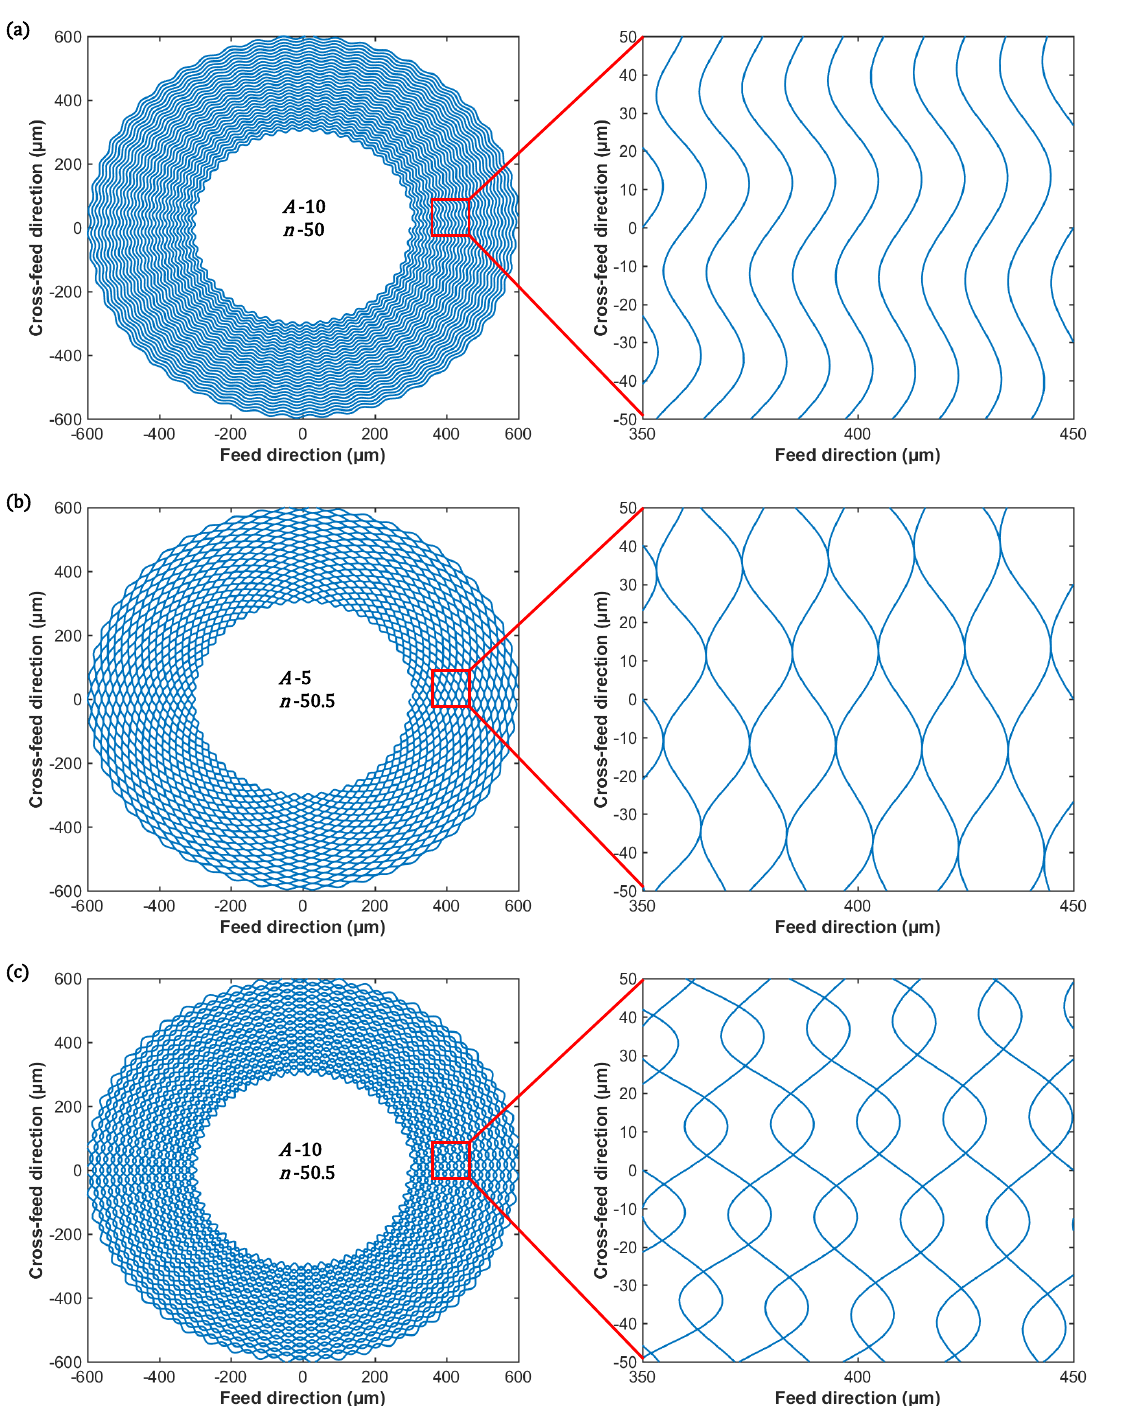
Figure 4. The toolpath simulations with three kinds of parameters combinations: ( a ) Non-contact-mode toolpath; ( b ) Contact- mode toolpath and ( c ) Cross-mode